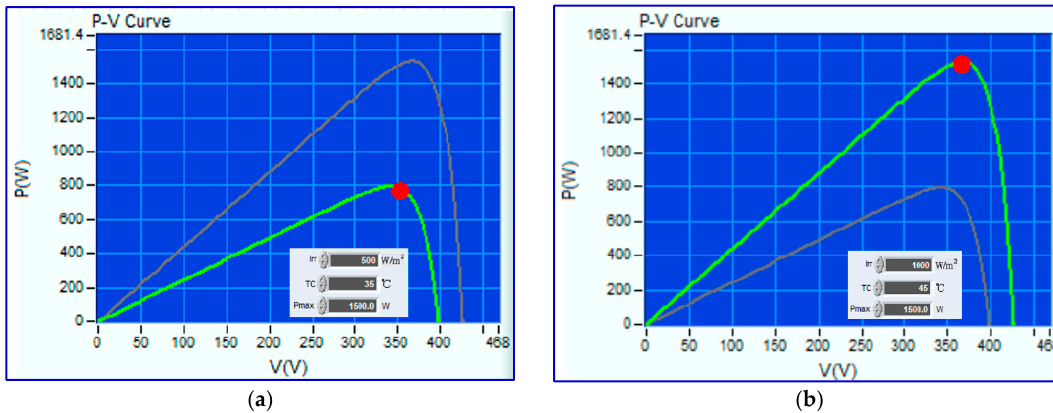
Figure 15. Experimental P–V tracking curve results of the change irradiation and change temperature. ( a ) 500 W/m 2 , 35 °C ( b ) 1000 W/m 2 , 45 °C.